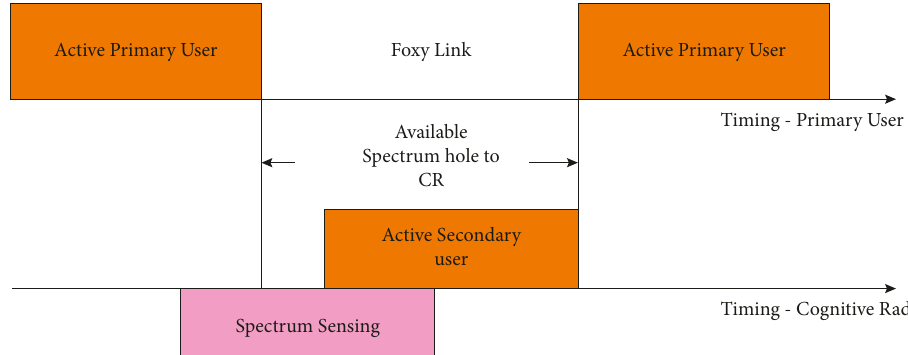
Figure 5: Impulsive connection in